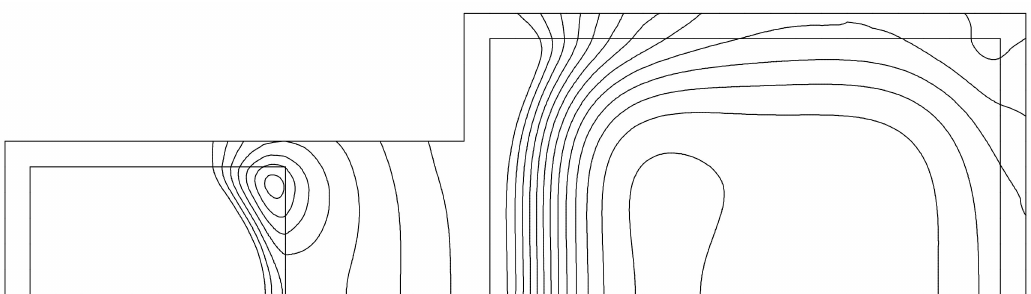
Figure 12. Contours of the imaginary part of the magnetic vector